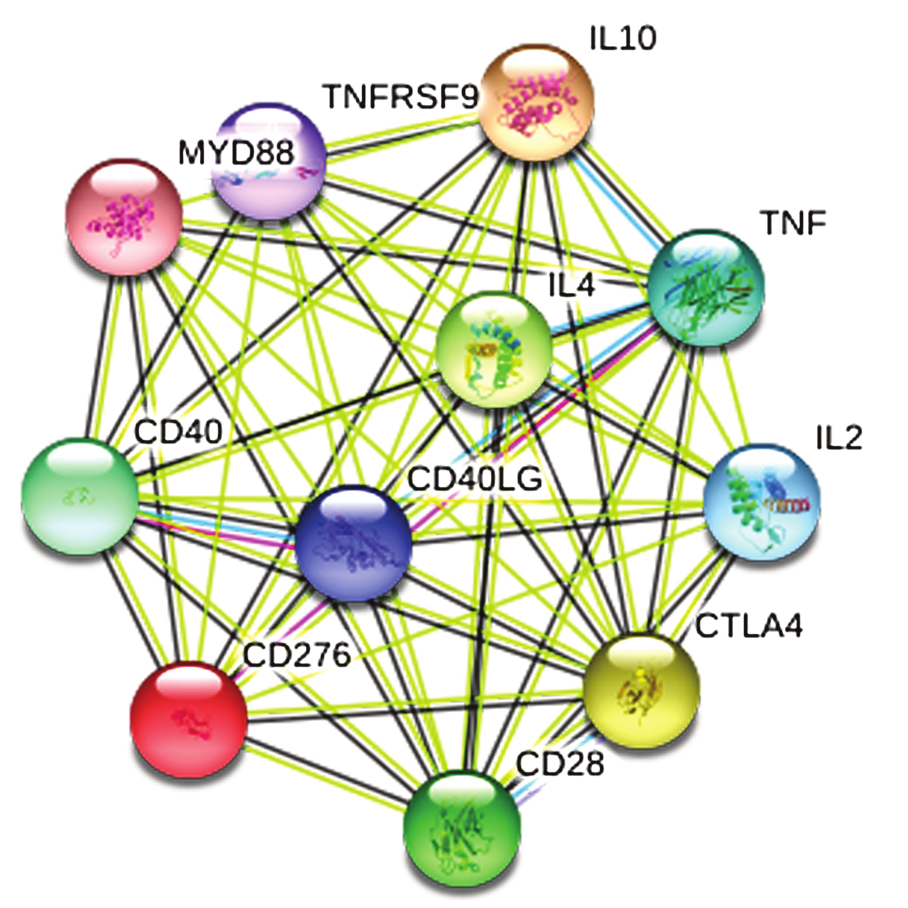
Figure 6: Protein network interacting with